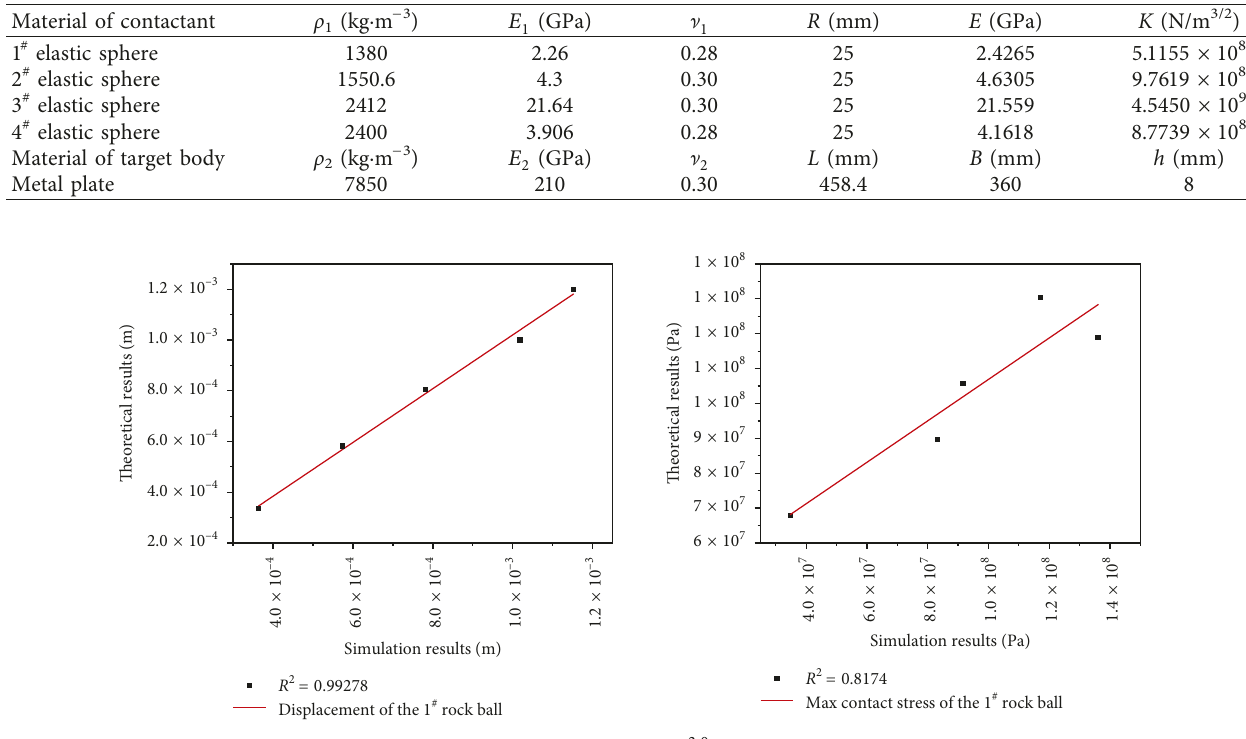
Table 2: Parameters of contact model of the elastic sphere and metal